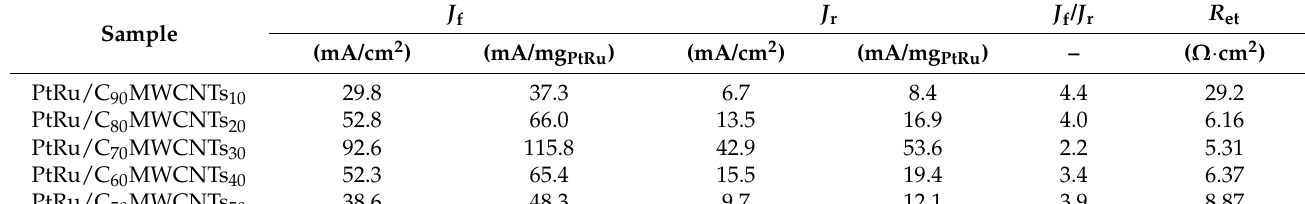
Table 3. Electrochemical parameters of PtRu/C 90 MWCNTs 10 , PtRu/C 80 MWCNTs 20 , PtRu/C 70 MWCNTs 30 , PtRu/C 60 MW CNTs 40 , and PtRu/C 50 MWCNTs 50 .